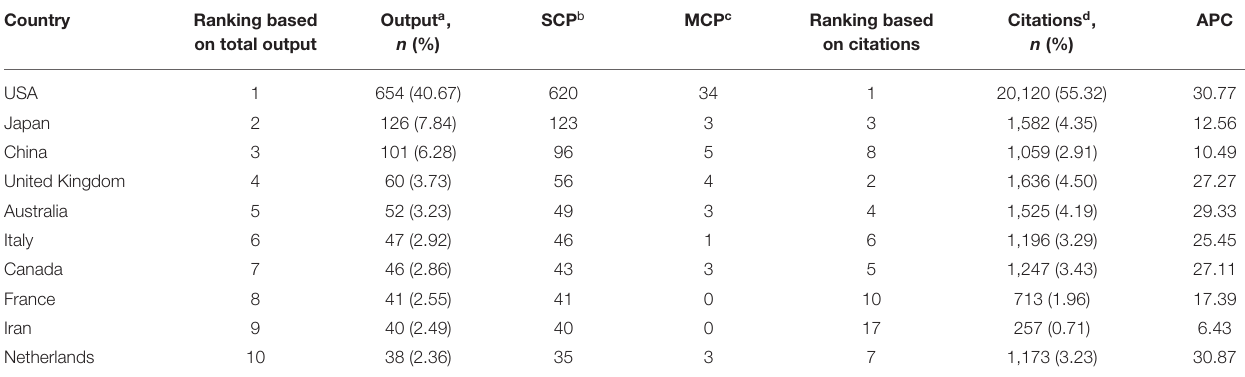
TABLE 1 | The top 10 countries contributing to publications on disaster epidemiology research.